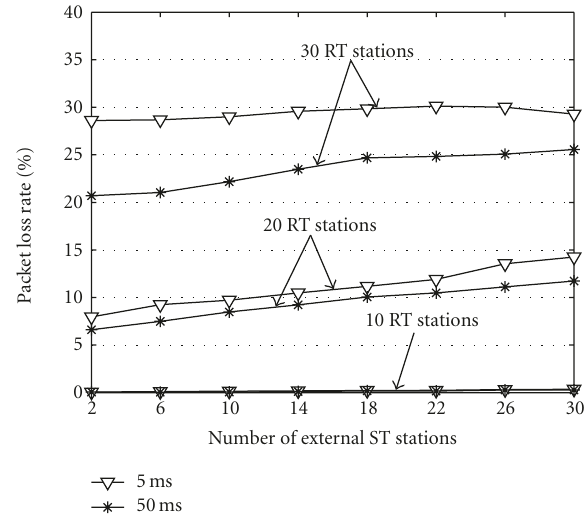
Figure 8: Packet loss rate—MSP = 5ms and 50 ms.